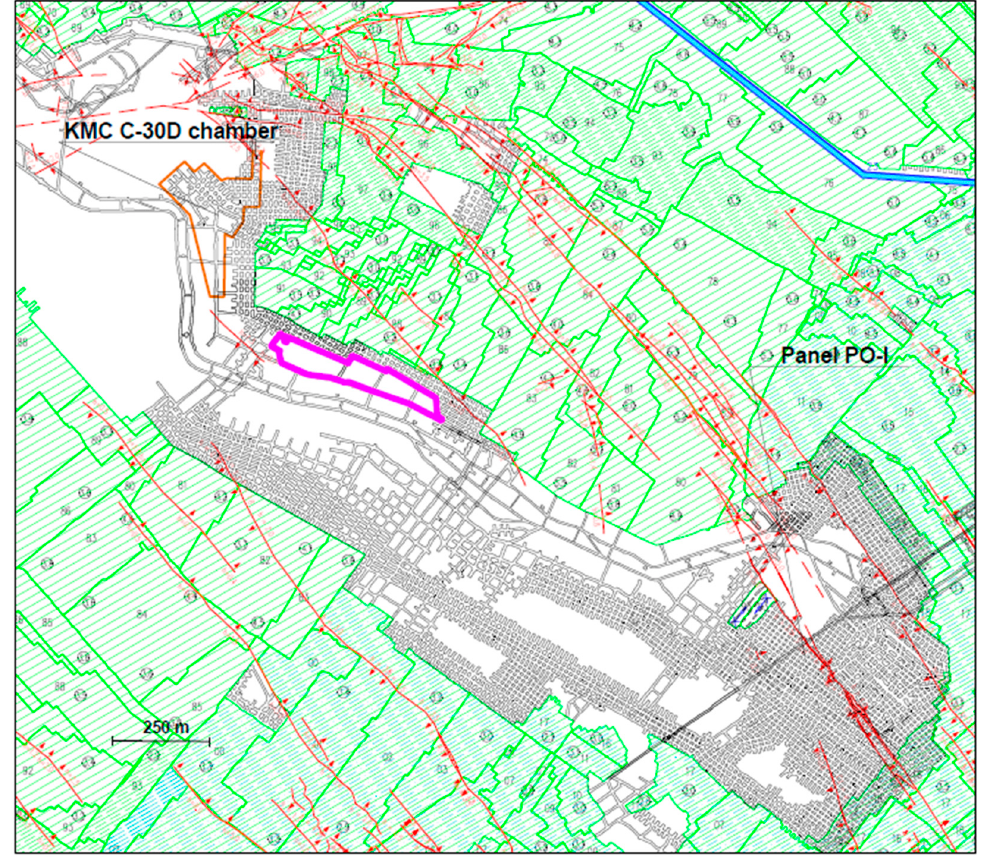
Figure 9. Location of the C-30D chamber against the background of the workings of the Polkowice- Sieroszowice mine (the moment of starting the measurements).